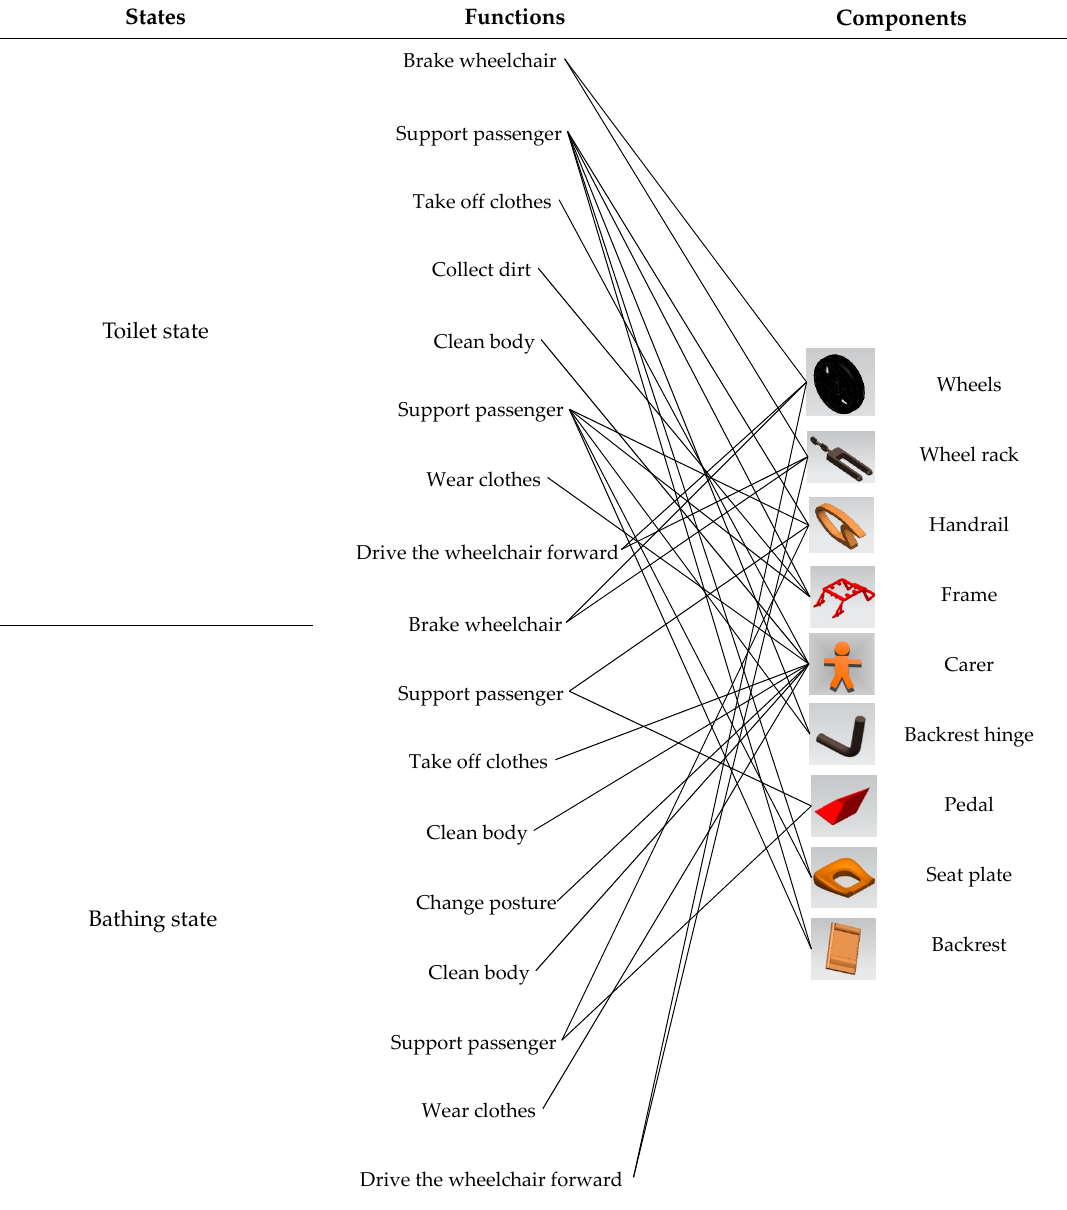
Table 8. Relationship between functions and components of the second concept.